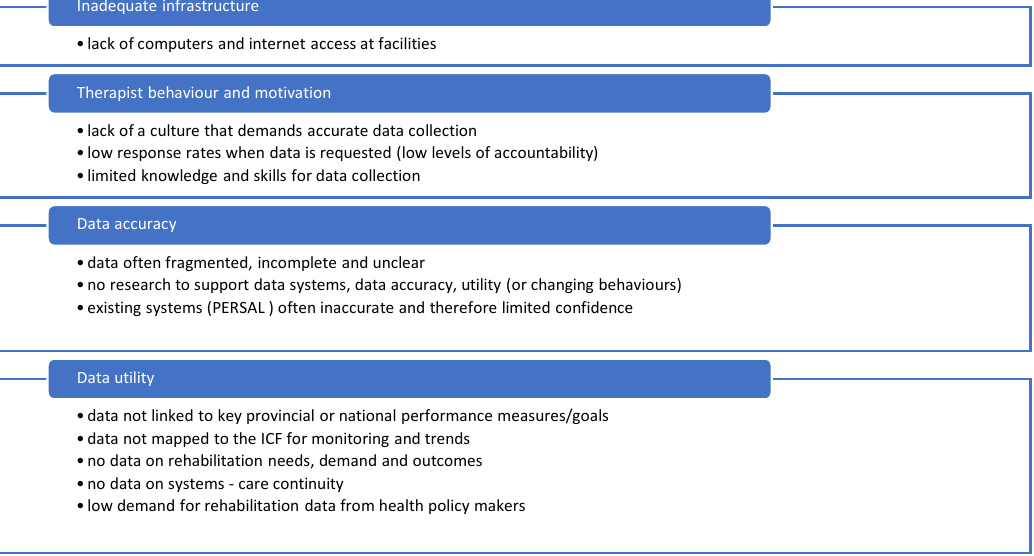
Figure 3. Summary of key findings pertaining to data and information technology.